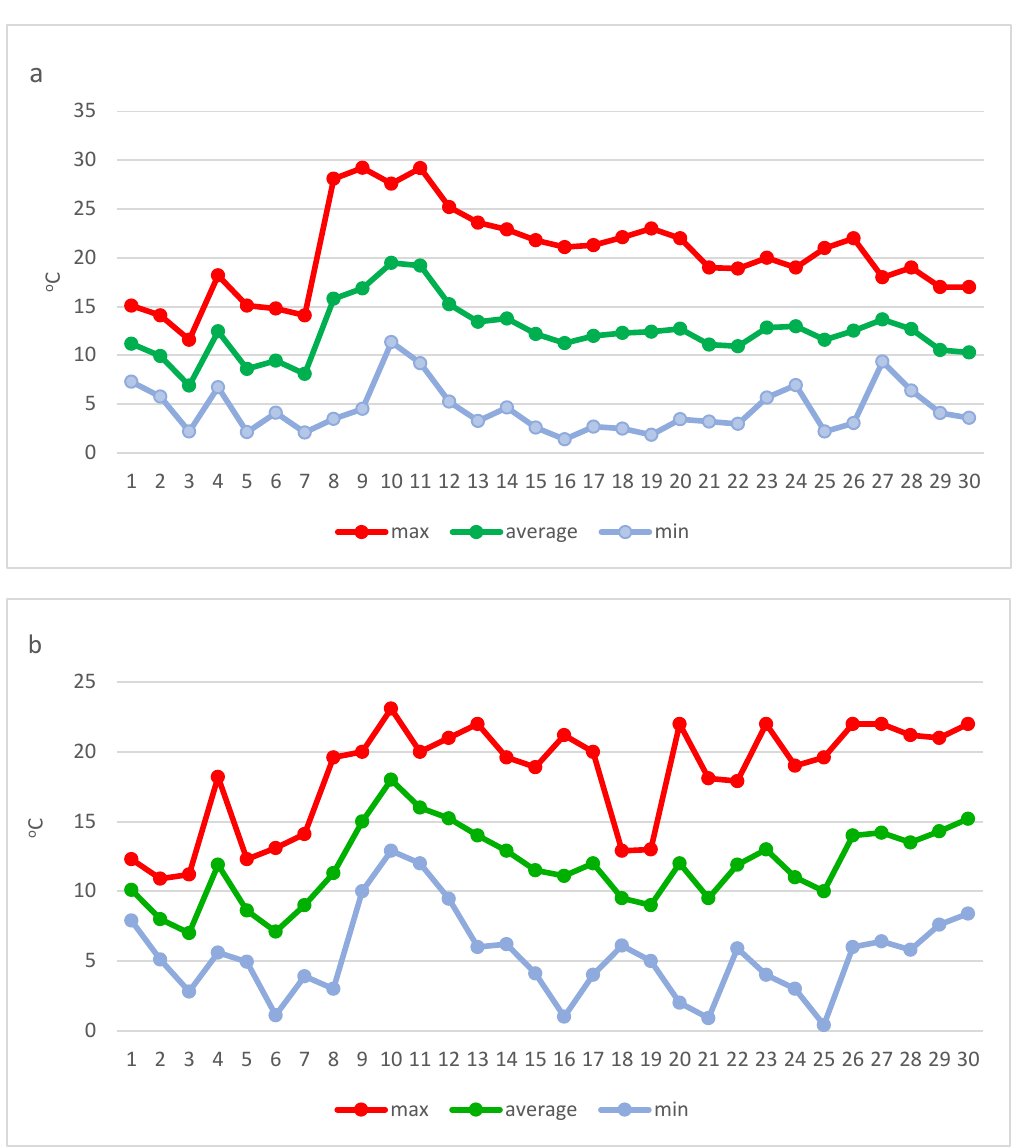
Figure 1. The course of maximum, average and minimum temperature in the periods of flowering. ( a ) — the first year of the experiment (2013 year); ( b ) — the second year of the experiment (2014 year).